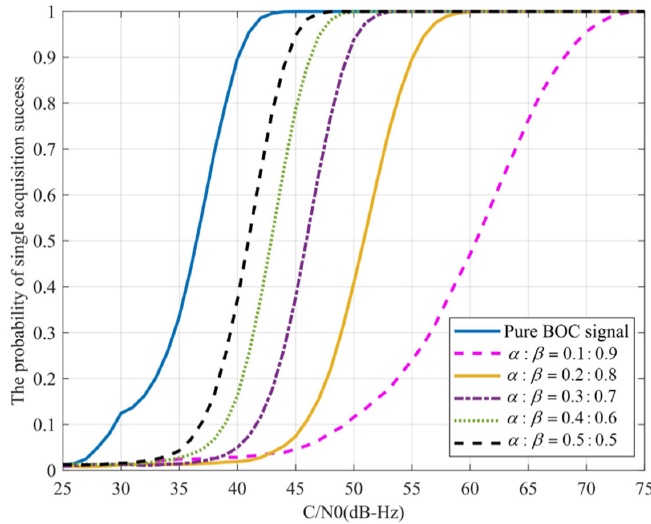
Figure 9. Single acquisition success probability under different situations.